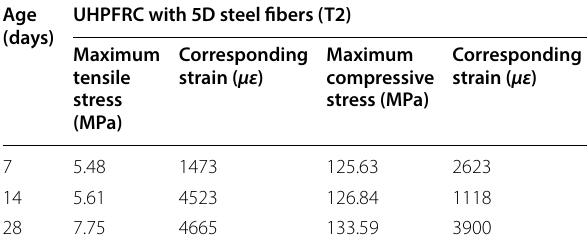
with modulus of elasticity for UHPFRC (T2) at different